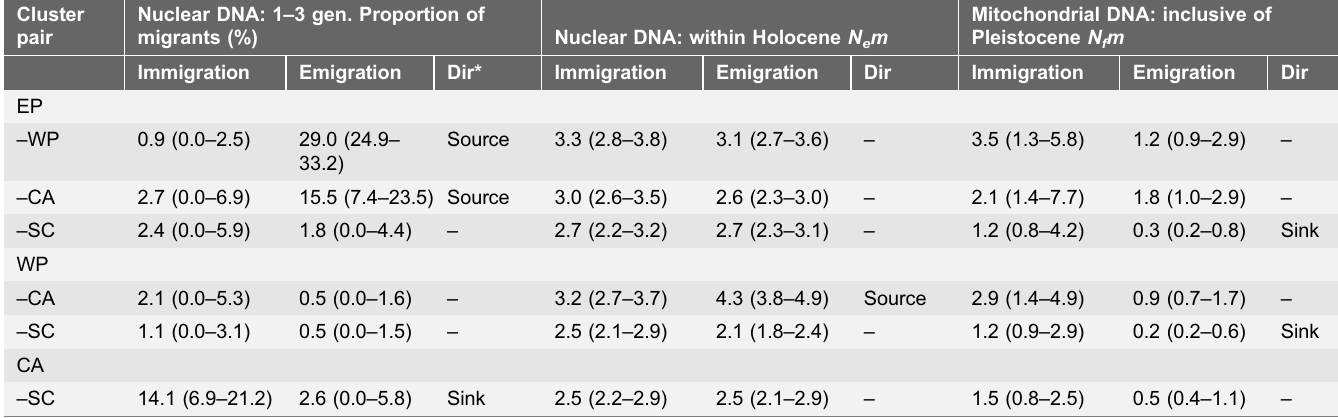
Table 1. Directional gene flow estimated based on allelic frequency (proportion of non-migrants, m ) in BAYESASS and based on the coalescent (effective number of migrants DNA N e m and female migrants N f m per generation) in MIGRATE between four clusters of polar bears calculated from microsatellite and mitochondrial control region data.